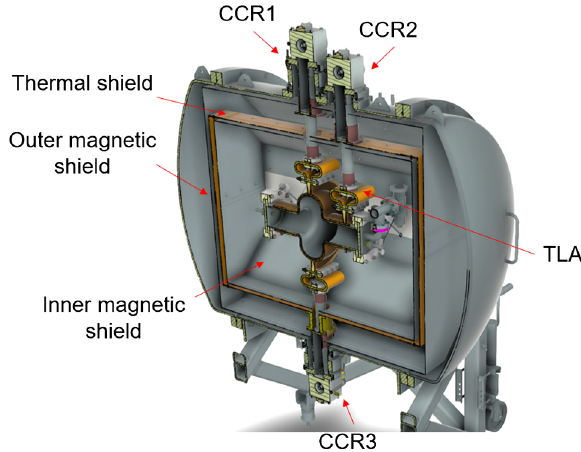
FIG. 19. Cross-section view of the 3D layout of the HTC on a support